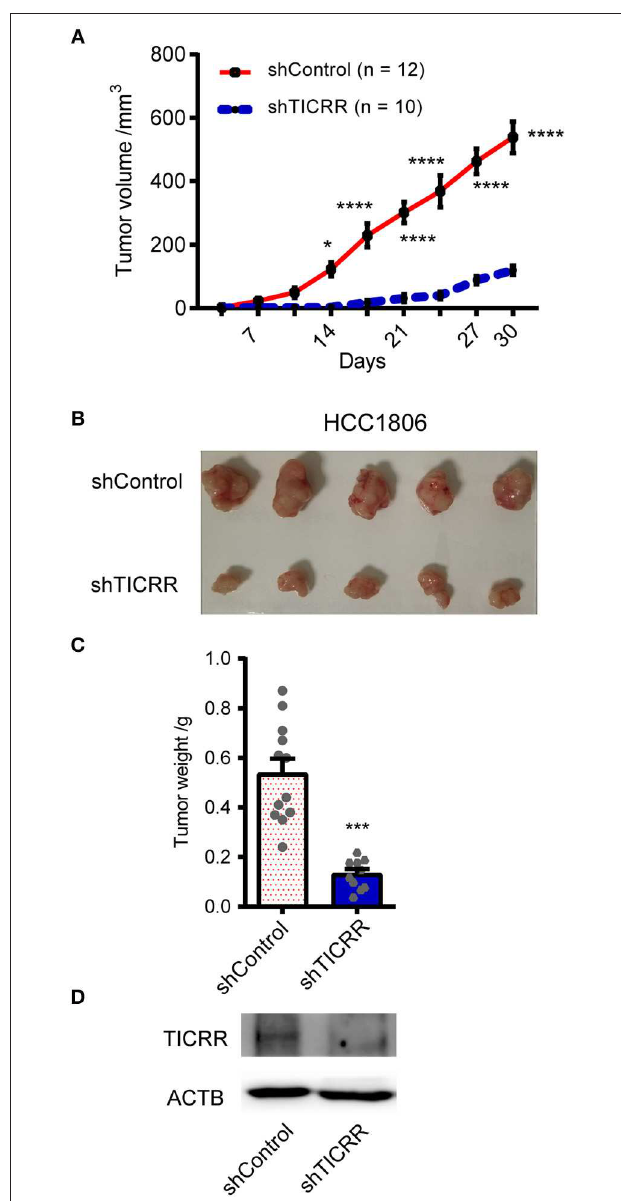
FIGURE 3 | Knockdown of TICRR inhibited tumor growth in vivo . (A) The xenograft tumor volume vs. days of post-injection was shown from BALB/c nude mice injected with shTICRR- and shControl- HCC1806 cells. * p -value < 0.05, **** p -value < 1.00 × 10 − 4 , two-way ANOVA test. Results were displayed as means ± SEM. (B) Representative photo of xenograft tumors. (C) Tumor weight. The tumor-bearing mice were sacrificed and the tumors were dissected out at the last day. The number of mice is 12 and 10 for the shControl and shTICRR group, respectively. *** p -value < 1.00 × 10 − 4 , two-tailed Student’s t test. Results were displayed as means ± SEM. (D) TICRR level in tumors harvested from mice at the last day.